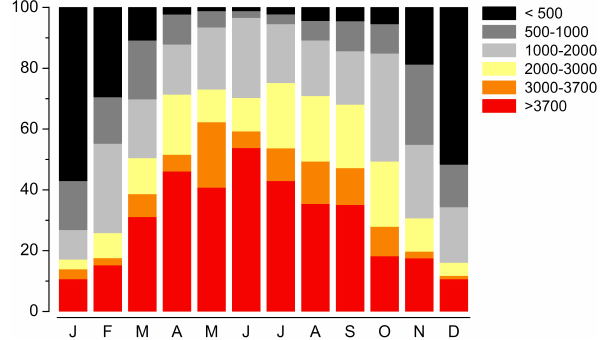
Fig. 6. Percentage distribution of the monthly averaged maximum boundary layer depth (in meters), inferred from the balloon data analysis at the Milano-Linate Airport meteorological station over the 2007–2009 years